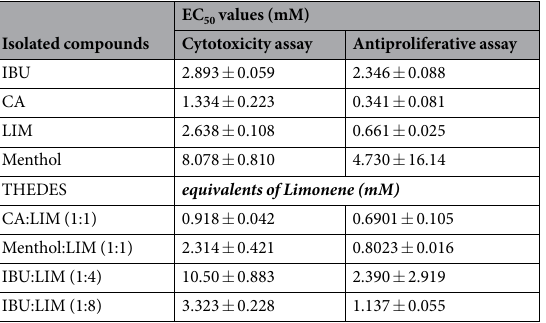
Table 2. EC 50 values obtained from cytotoxicity and antiproliferative assays of isolated compounds and THEDES in Caco-2 and HT29 cells, respectively. Results were expressed in mean ± SD of equivalents of LIM.